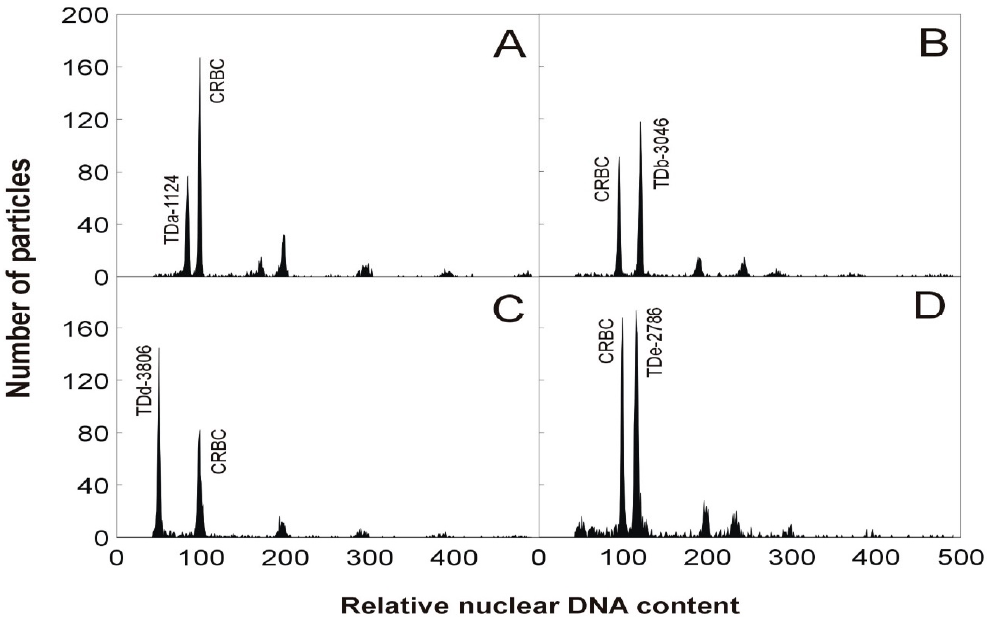
Figure 3. Histograms of relative nuclear DNA content obtained after simultaneous flow-cytometric analysis of DAPI-stained nuclei isolated from fresh leaf tissues of Dioscorea accessions and chicken red blood cell nuclei (CRBC). The gain of the instrument was adjusted so that the G1 peak of CRBC nuclei, which served as an internal reference standard, was positioned on channel 100. Peaks appearing on channels 200, 300, 400 and 500 correspond to doublets, triplets, etc. of CRBC nuclei. ( A ) Dioscorea alata (TDa-1124), peak ratio = 0.85; ( B ) D. bulbifera (TDb-3046), peak ratio = 1.27; ( C ) D. dumetorum (TDb-3806), peak ratio = 0.51; ( D ) D. esculenta (TDes-2786), peak ratio = 1.